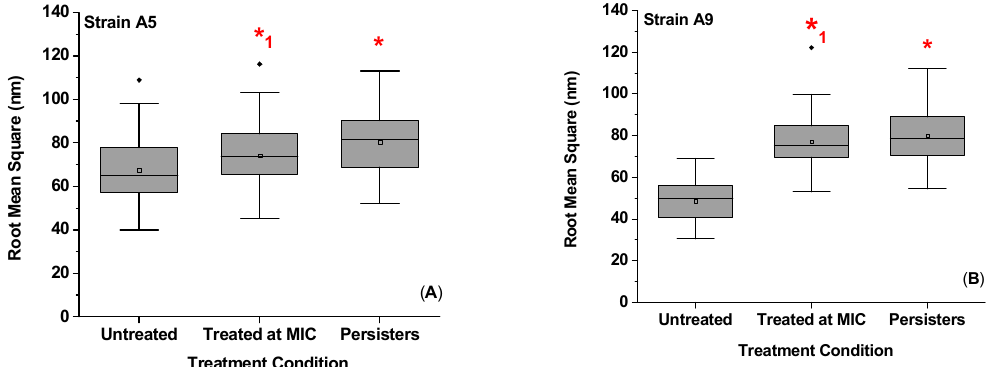
Figure 5. The average bacterial surface RMS in nm obtained on 0.60 × 0.60 µm 2 areas of surfaces of cells that belong to Strain A5 ( A ) and Strain A9 ( B ) for variable treatments. For Strain A5, 45, 30, and 34 cells were probed, respectively, whereas, for Strain A9, 38, 45, and 39 cells were plotted, respectively. * Values are statistically significant between untreated and treated cells. * 1 Values are statistically significant from untreated cells but not from the treated groups, p < 0.001, n = 3 independent cultures.